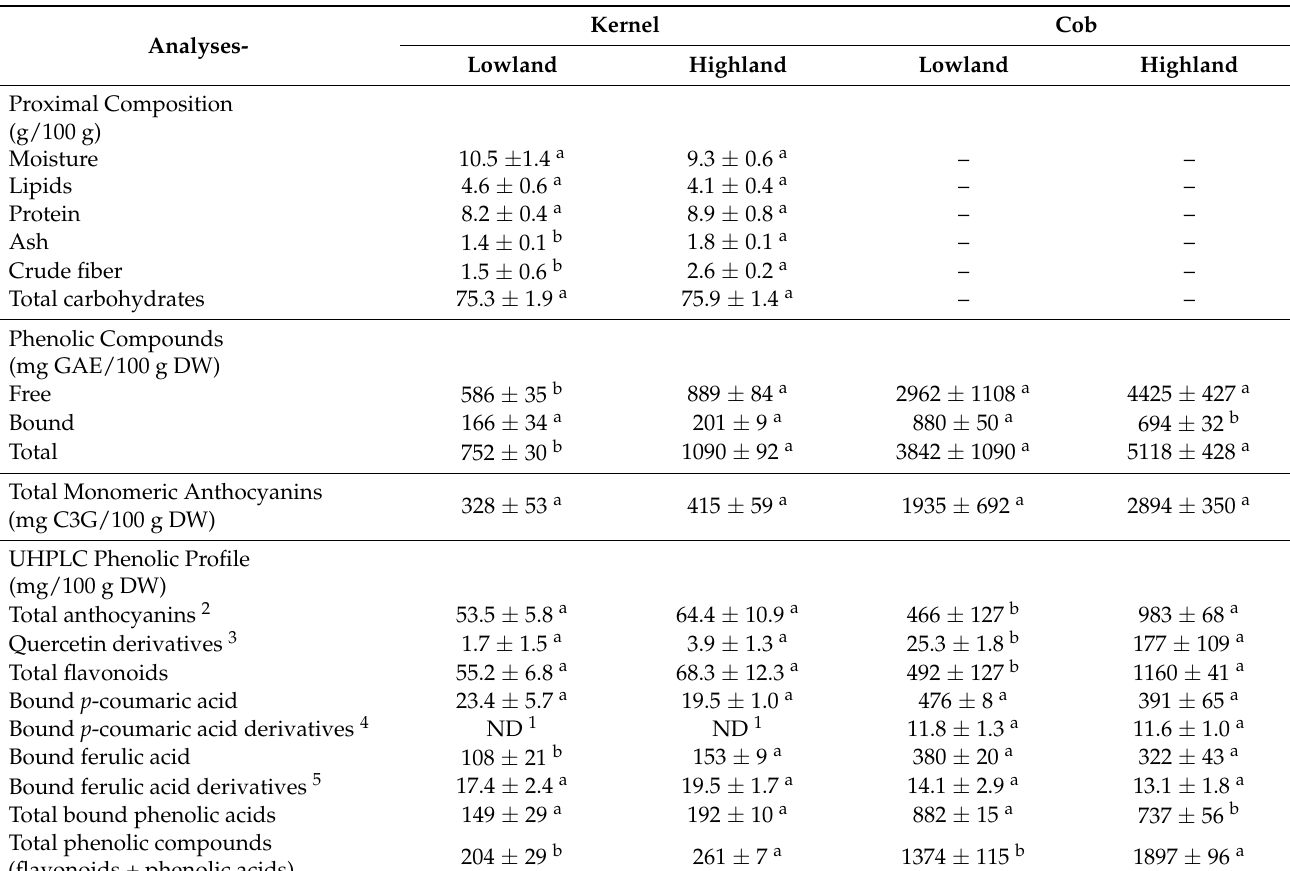
Table 2. Proximal composition and phenolic compounds in purple corn kernel and cob from lowland and highland geographical zones in